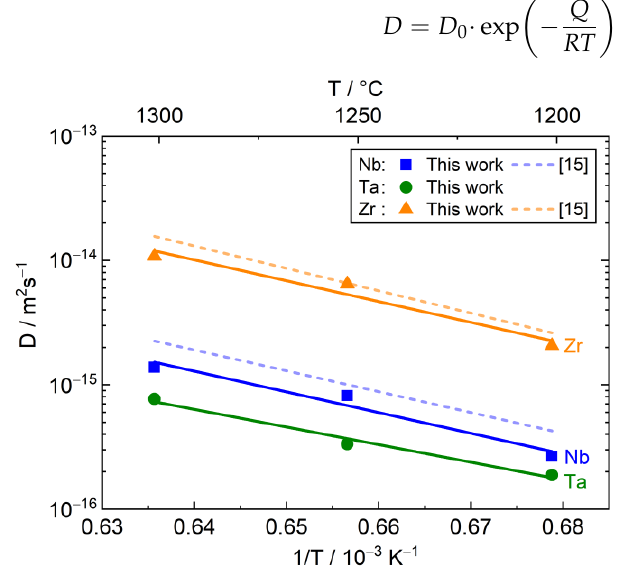
Table 3. Activation energy Q and frequency factor D 0 of the alloying elements Niobium, Tantalum and Zirconium in γ -Ti-54Al.